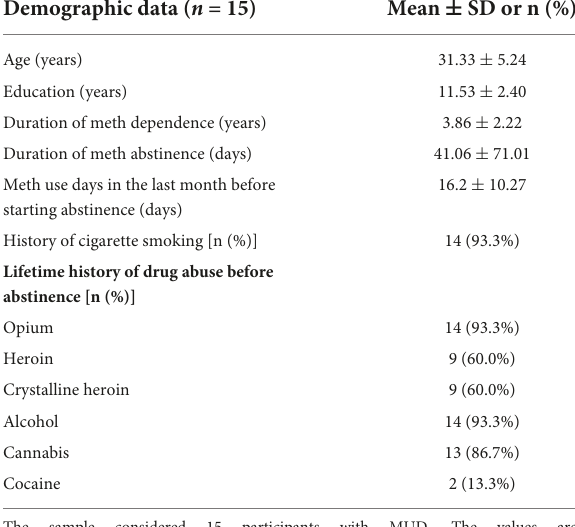
TABLE 1 Demographic data and substance use